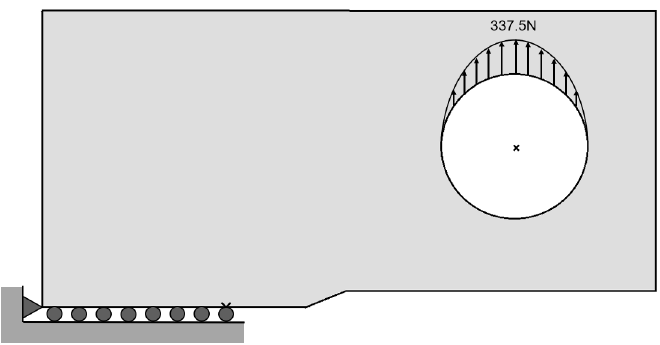
Figure 4. Boundary conditions applied to the CT